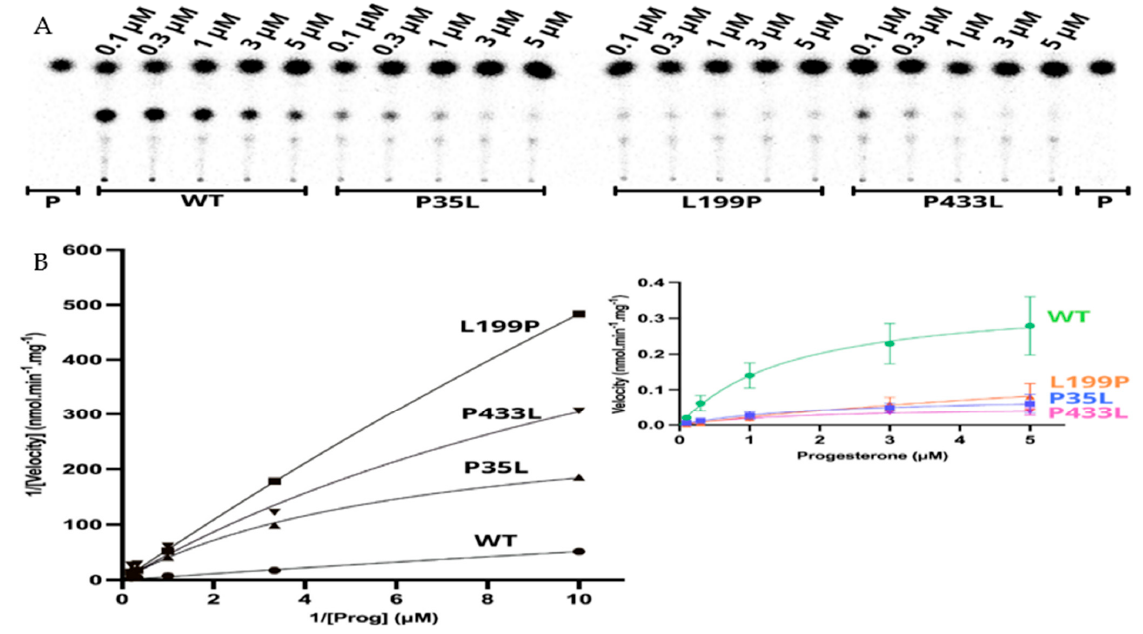
three replicates shows the CYP21A2 conversion of progesterone (Prog) (0.1, 0.3, 1, 3, and 5 µ M) into 11-deoxycorticosterone (DOC). ( B ) The left-hand plot presents the linear plots of enzymatic activity of 21OH WT and mutations between 1/Velocity against 1/Prog (progesterone concentration) for the conversion of progesterone to DOC. Additionally, the right-hand plot presents the Michaelis Menten nonlinear curve with velocity reactions against the substrate progesterone used to obtain V max and K m